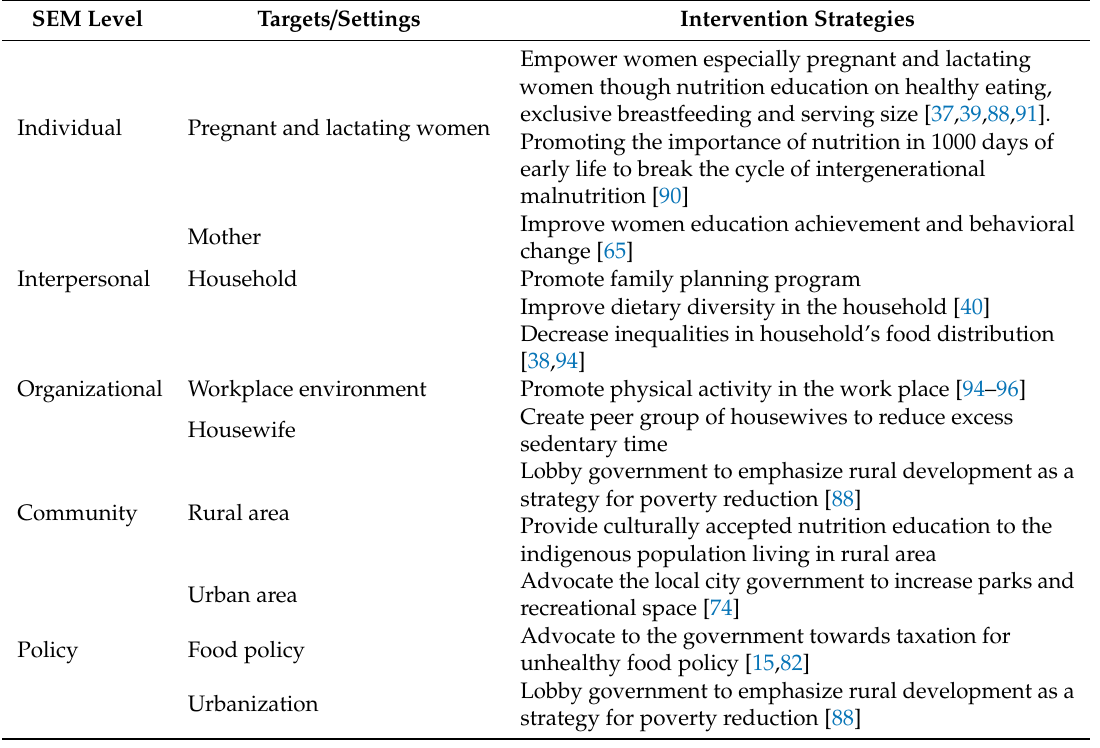
Table A2. Potential intervention targets / settings and strategies that utilize a socio-ecological